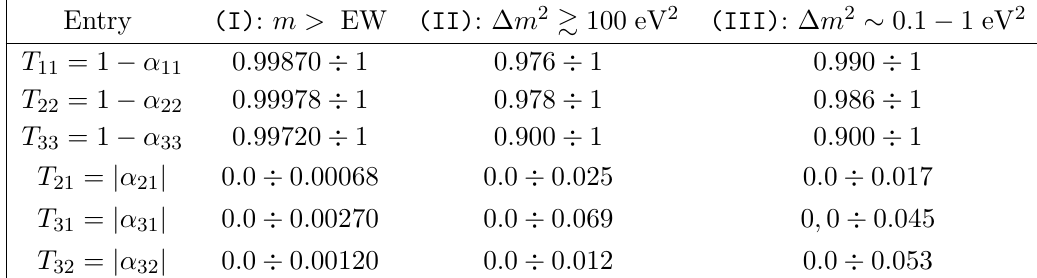
Table 1 . Limits on the elements of the T = I (cid:0) (cid:11) matrix for di(cid:11)erent non-standard neutrino mass scenarios (I) - (III) . Limits on the (cid:11) matrix elements (cid:11) ij are taken from [46] (with 95% CL), which are obtained from the global (cid:12)ts [52] to the experiments [53{57]. Moreover, these data also